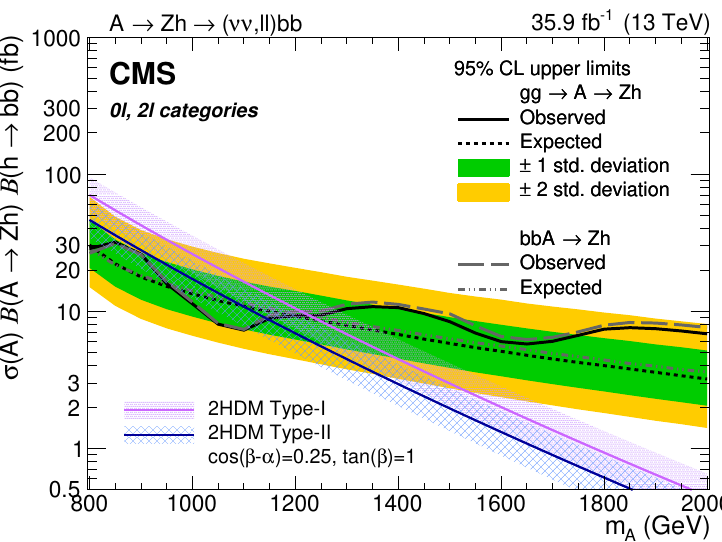
(A Zh) (h bb) as a B ! B !